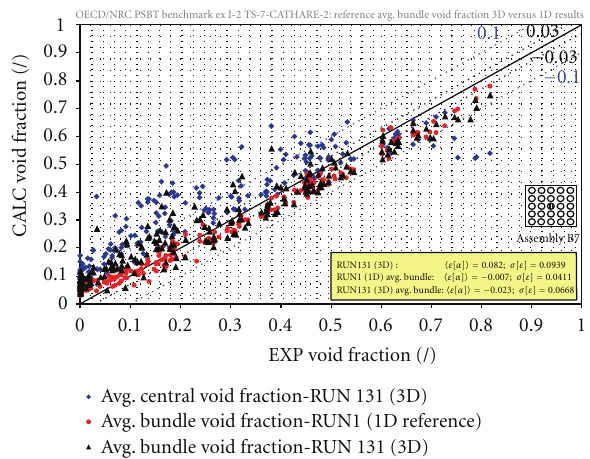
Figure 7: PSBT steady-state bundle (TS 7)—CATHARE2 3D and 1D models: central and bundle void fraction exp. versus calc., reference results.